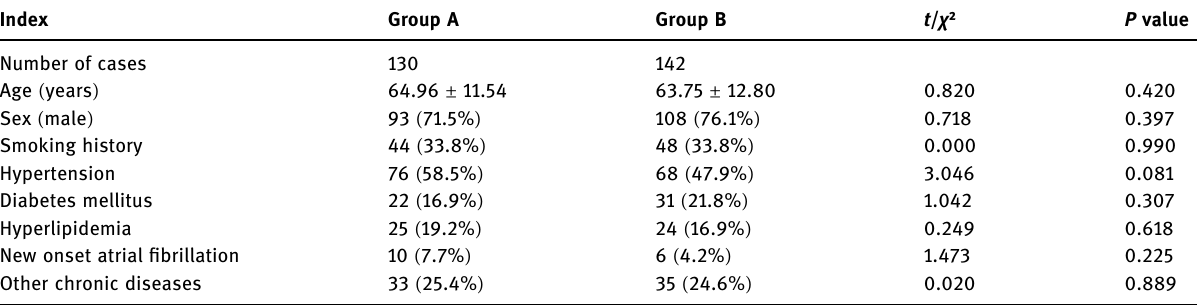
Table 1: Comparison of baseline characteristics between groups ( %, mean ± SD